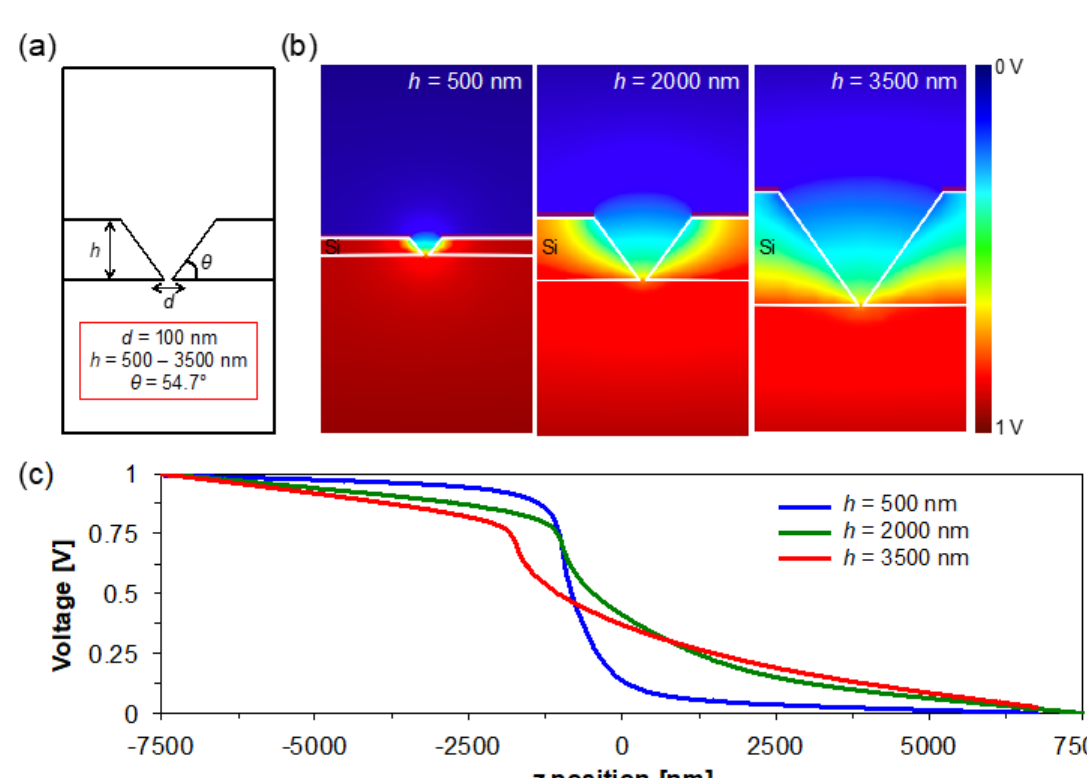
Figure A2. Dependence of the electric field distribution on the thickness of Si membrane for the Si 3 N 4 / Si-based nanopore structures. ( a ) Schematic illustration of the simulation model. ( b ) Cross-sectional potential distributions for the nanopores with h = 500 nm, 2000 nm, and 3500 nm. It was found that higher thickness causes more gradual potential drop in a nanopore device. ( c ) Potential dependences on z position on the center axis ( x = 0, y = 0) for the nanopores with h = 500 nm (blue), 2000 nm (green), and 3500 nm